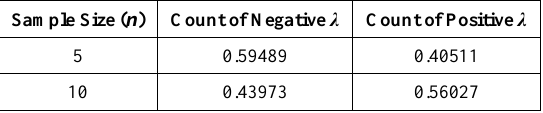
Table 2. Increased simulation runs for sample sizes 5 and